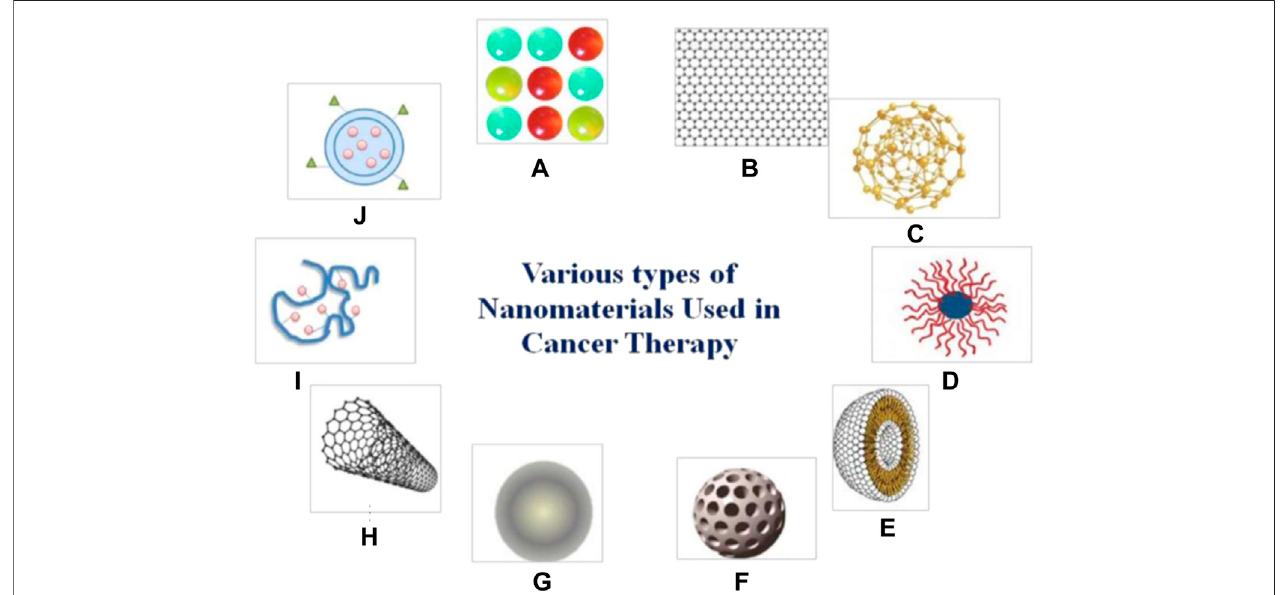
FIGURE 1 | Different types of nanomaterials which are used in cancer treatment (A) quantum dots. (B) grapheme. (C) gold nanoparticles. (D) polymeric micelles. (E) liposomes. (F) silicananoparticles. (G) magneticnanoparticles. (H) carbonnanotubes. (I) polymer-drugconjugates. (J) polymericnanoparticles.Reprinted(adapted) with permission from Rai et al. (2021). Medicina (Kaunas). 2021,57 (2),91. Copyright 2021 by the authors.